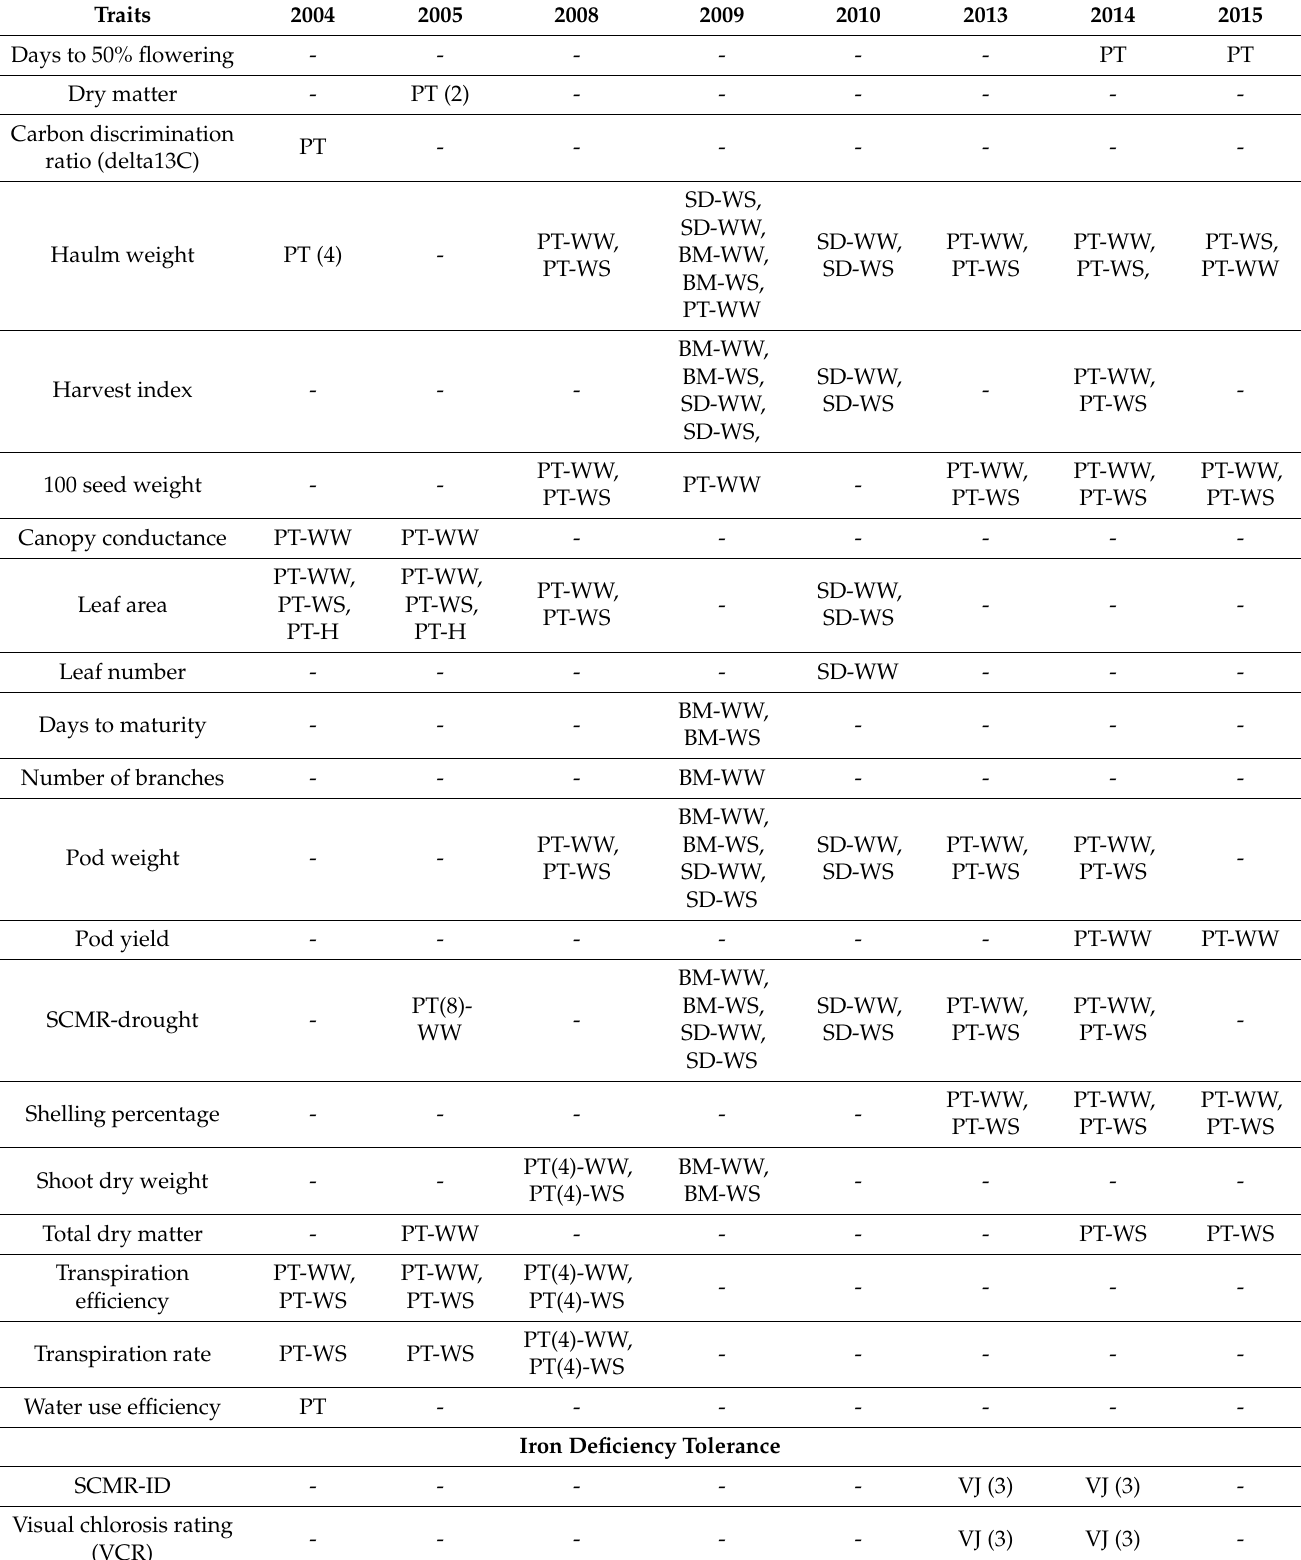
Table 1. Summary of phenotyping data generated for drought tolerance- and iron deficiency tolerance-related traits on